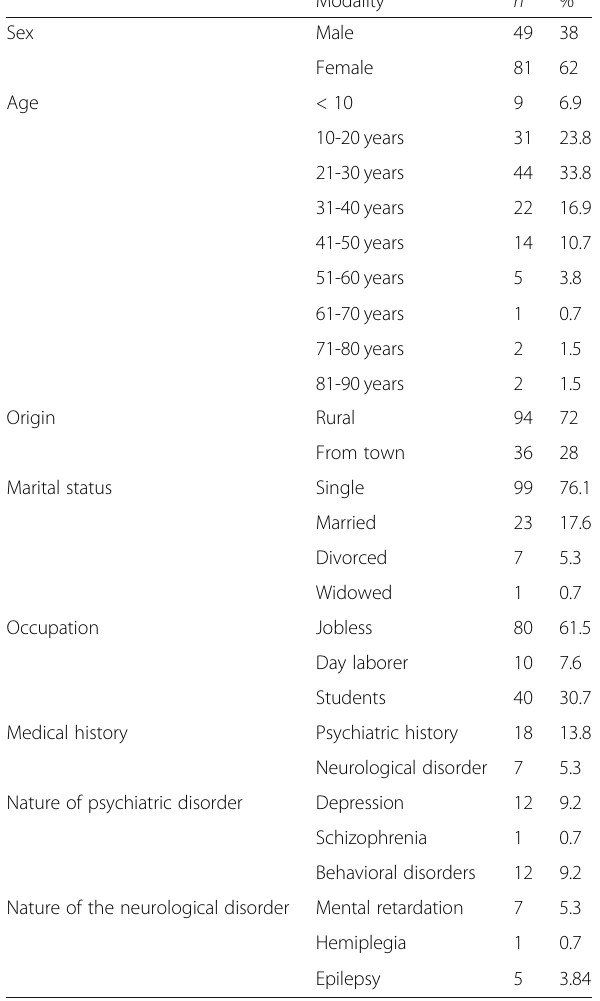
Table 1 Sociodemographic and medical characteristics of the victims